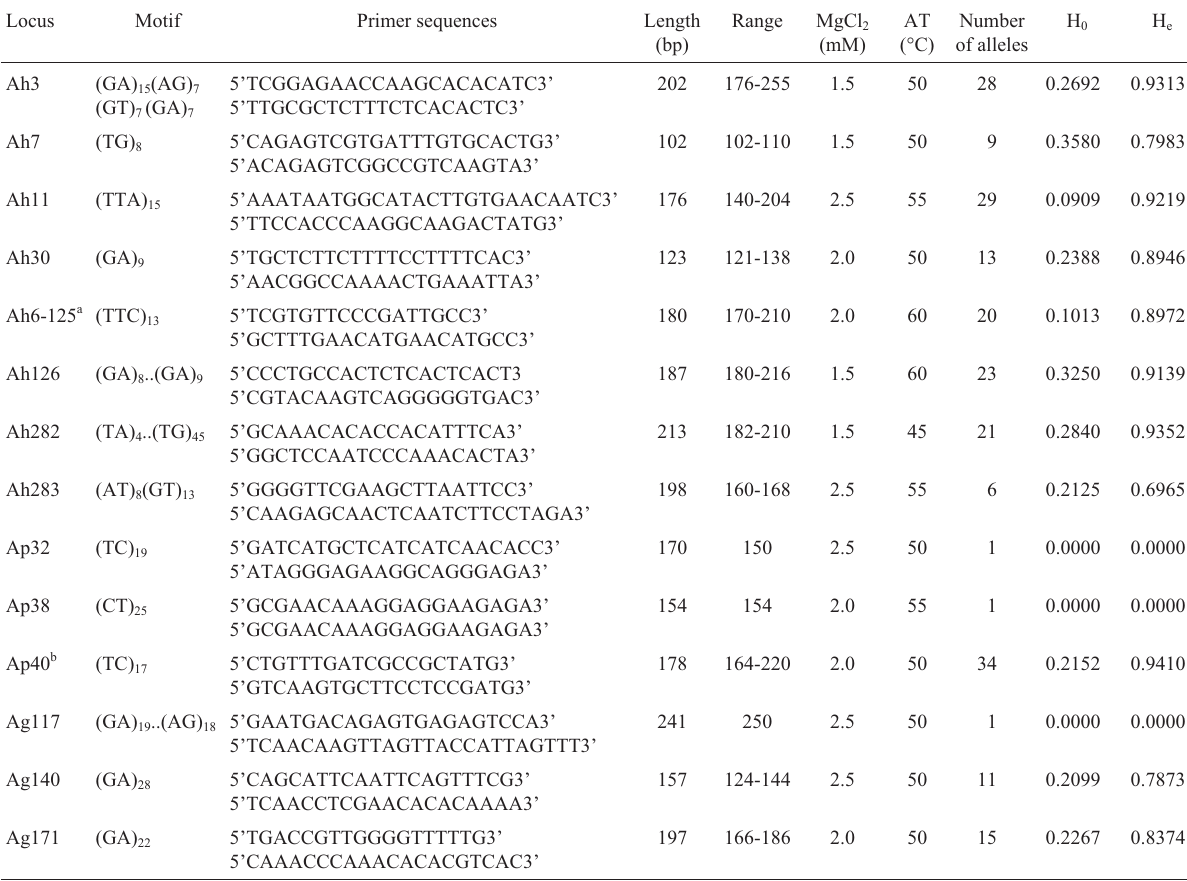
Table 2 - Microsatellite loci analyzed, motifs, primer sequences, expected length in the focal species, MgCl 2 concentration per reaction, annealing temperatures, number of alleles per locus and observed (Ho) and expected (He) heterozygosity values.